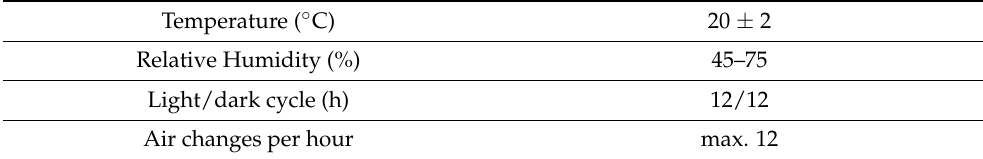
Table 1. Animal housing conditions.